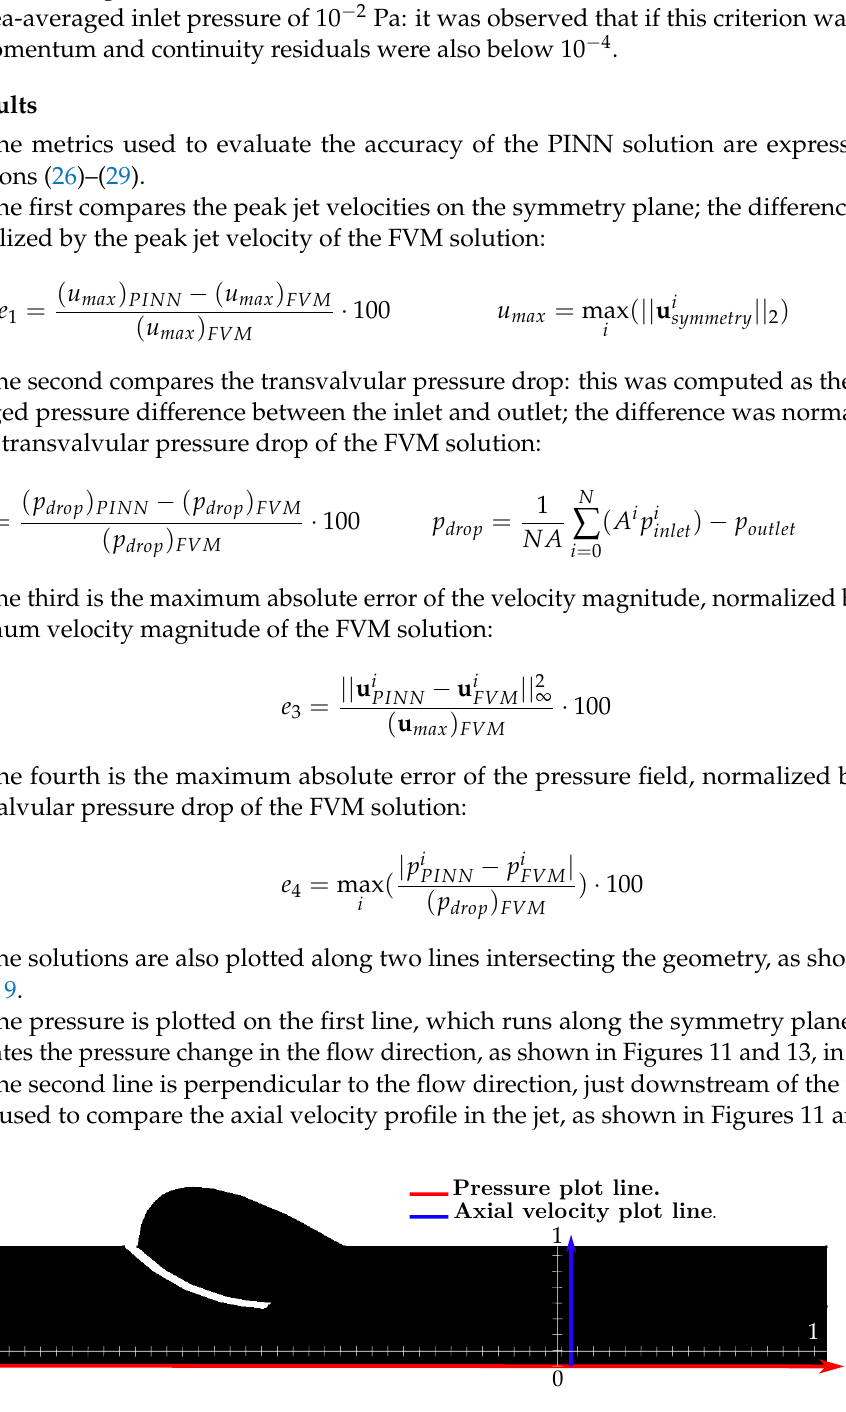
Figure 9. Intersect plot: the pressure field is plotted along the red line, and the axial velocity field is plotted along the blue